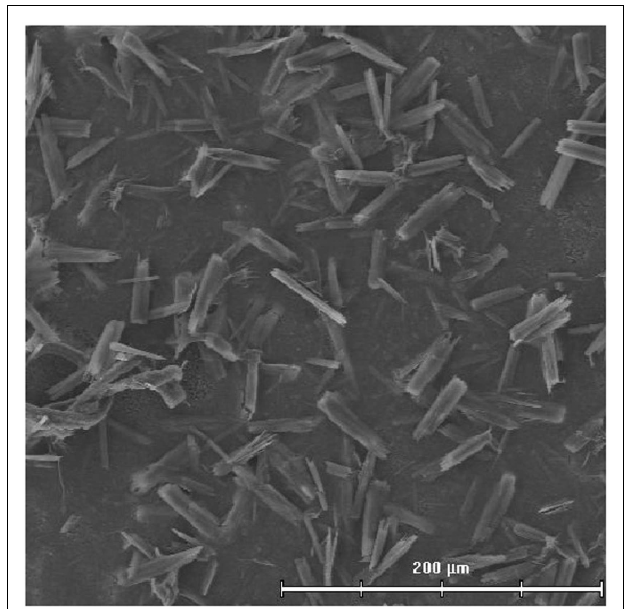
FIGURE 3 | Electron photograph ofAFCo1 obtained by close cycle technology